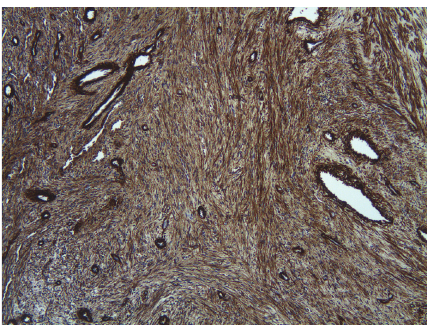
Figure 3: Bland spindle cell proliferation with nodular appearance andfocalhemangiopericytoma-likevasculature(hematoxylin-eosin stain, original magnification × 100).